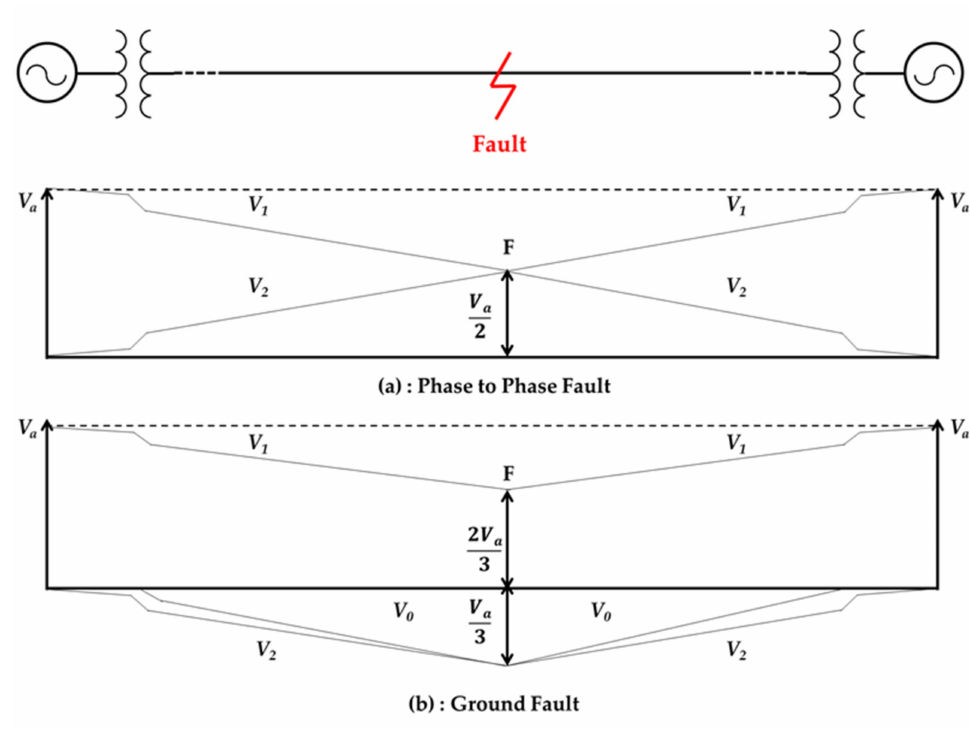
Figure 6. Size of voltage symmetric component by fault; ( a ) Phase to Phase Fault; ( b ) Ground